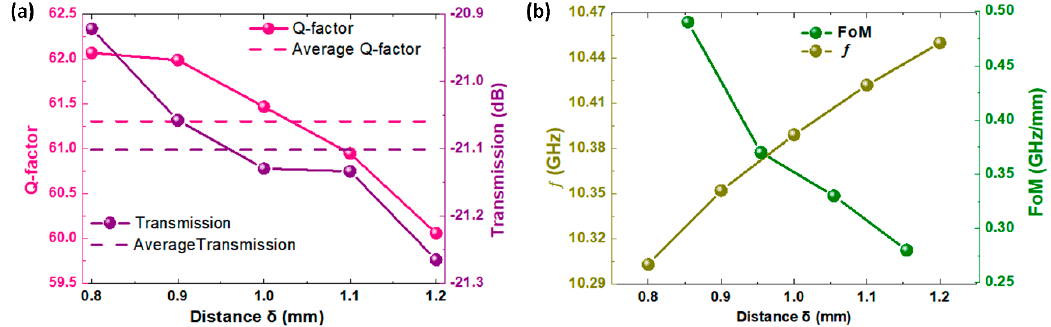
Figure 2. ( a ) Calculated Q-factors (pink dots) and simulated transmission amplitude (purple dots) of metamolecules with distances of 𝛿 = 0.8 mm, 0.9 mm, 1.0 mm, 1.1 mm and 1.2 mm. Calculated average Q-factors (pink dash lines) and transmission amplitude (purple dash lines) with the above distances 𝛿 . ( b ) Simulated resonance frequencies ƒ (dark yellow dots) and calculated figure of merit (FoM) (green dots).